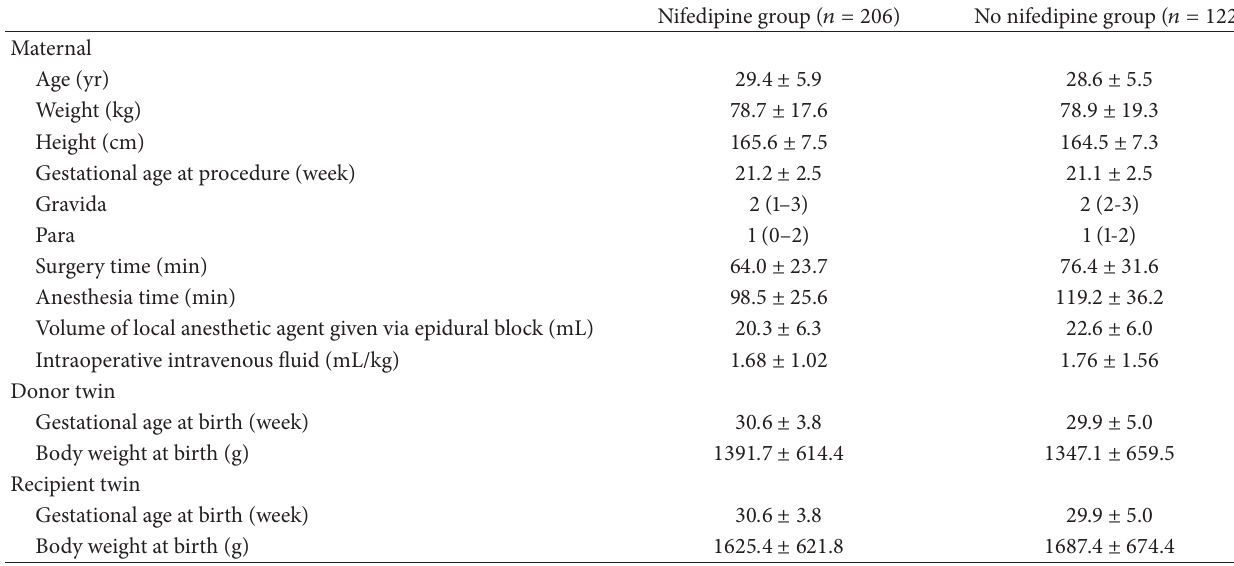
Table1:Studypopulationcharacteristicsofnifedipineexposuregroupandnonexposuregroup.Therewasnostatisticallysignificantdifference in maternal and fetal demographic data between these two groups.